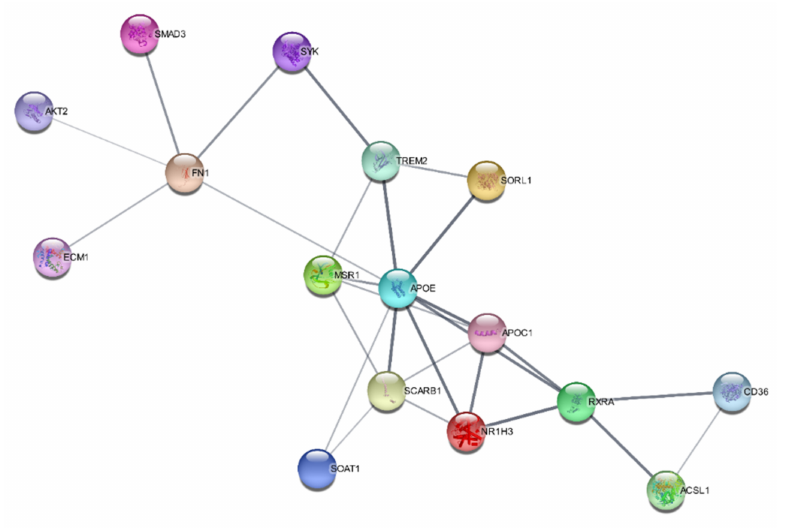
Figure 8. Protein–protein interaction networks constructed for the IFN- γ + kaempferol group, predicted by the STRING